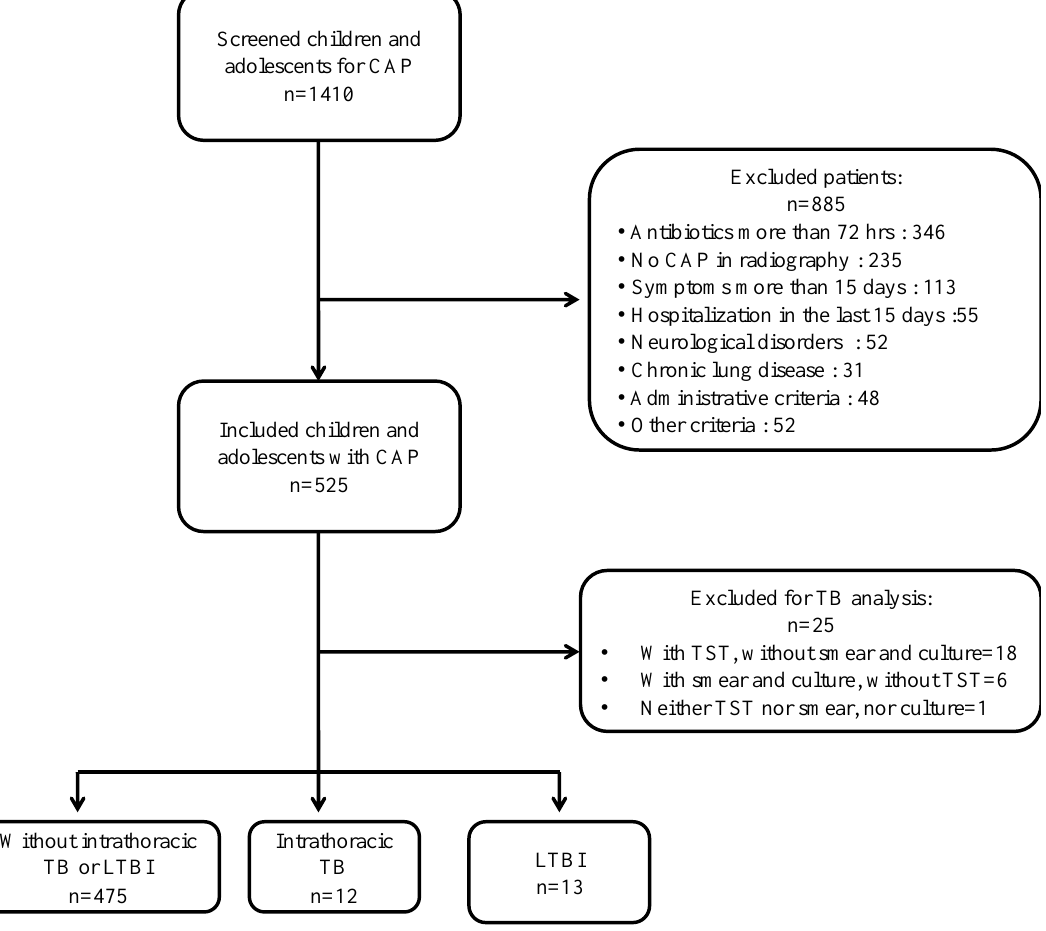
Figure 1. Flow chart of included patients.